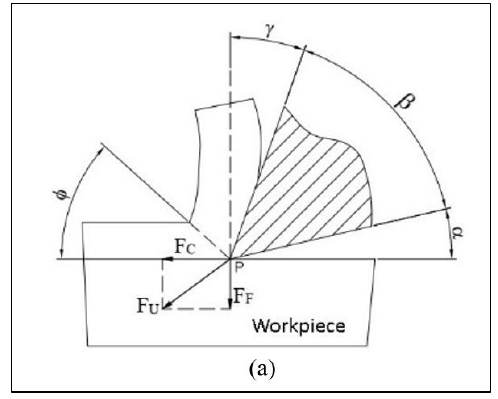
Figure 1a: Machining force components in the work plan: a) cutting force (F C ) and feeding force (F F